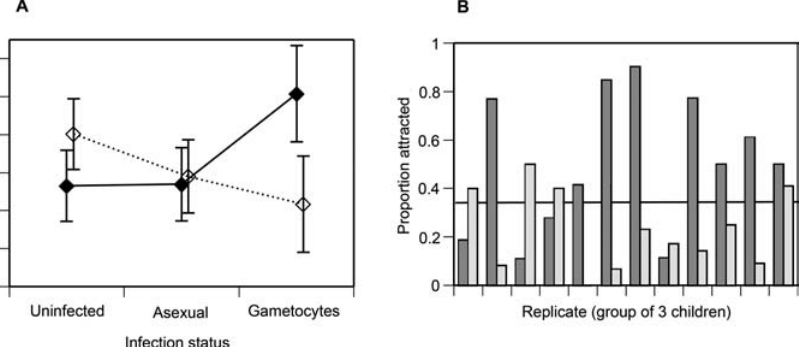
Figure 2. Graphical Representation of Results (A) Number of mosquitoes attracted to each class of children. Points show means of 12 groups; vertical lines show standard errors of the means. Solid diamonds show data of children before treatment; open diamonds denote children after treatment. (B) Proportion of the responsive mosquitoes (i.e., the ones that were attracted to any of the children within a group) attracted to the children who harboured gametocytes (before treatment; dark bars) and to the children who had cleared their gametocytes (after treatment; light bars). The horizontal line shows the proportion expected if the mosquitoes showed no preference. DOI: